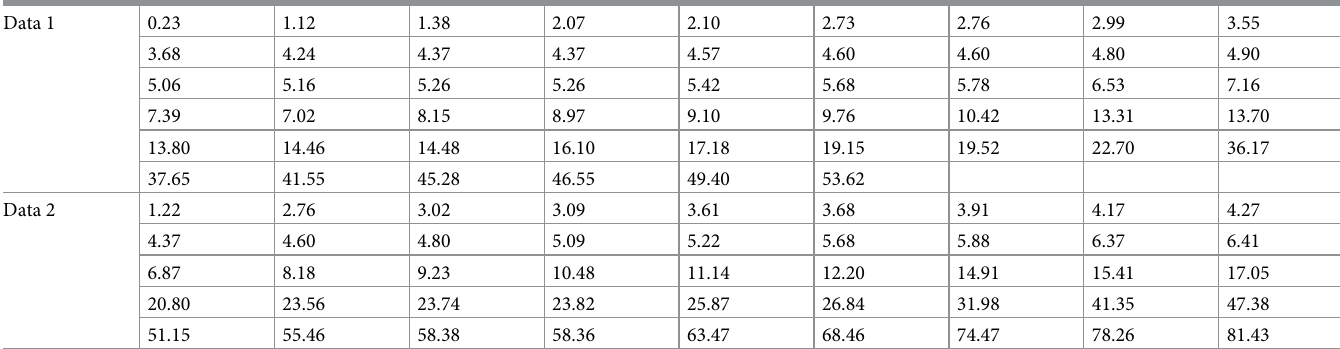
Table 16. Survival times (in months) for data 1 and data 2.